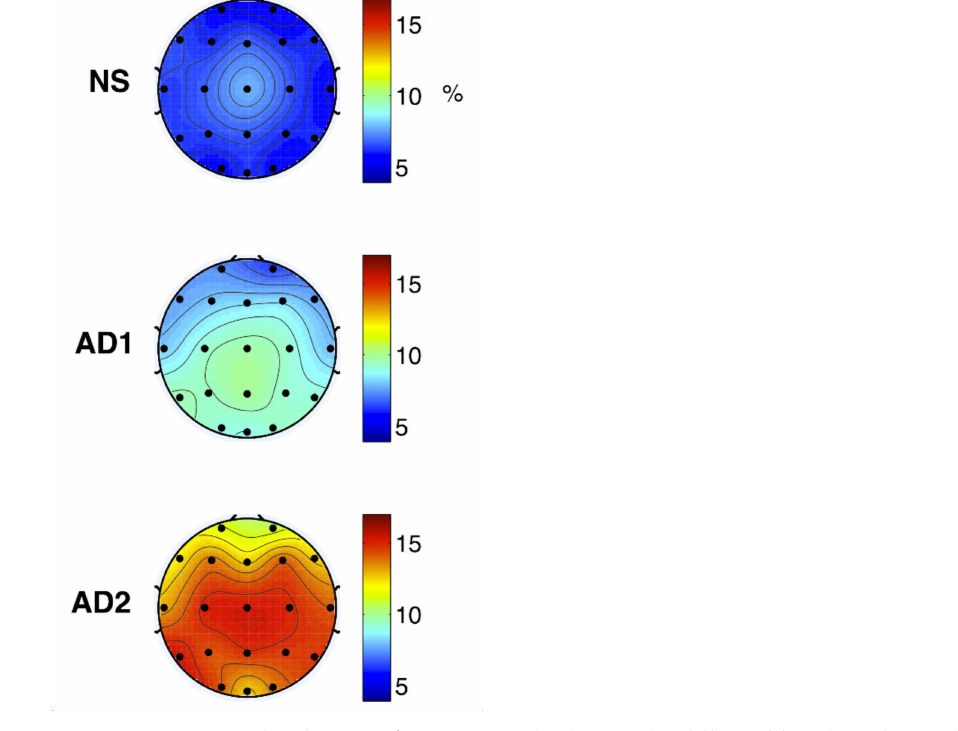
Figure 12. Topographical maps of average NS (top), AD1 (middle; mild AD), and AD2 (bottom; moderate AD) modulation frequency responses (reproduced with permission from